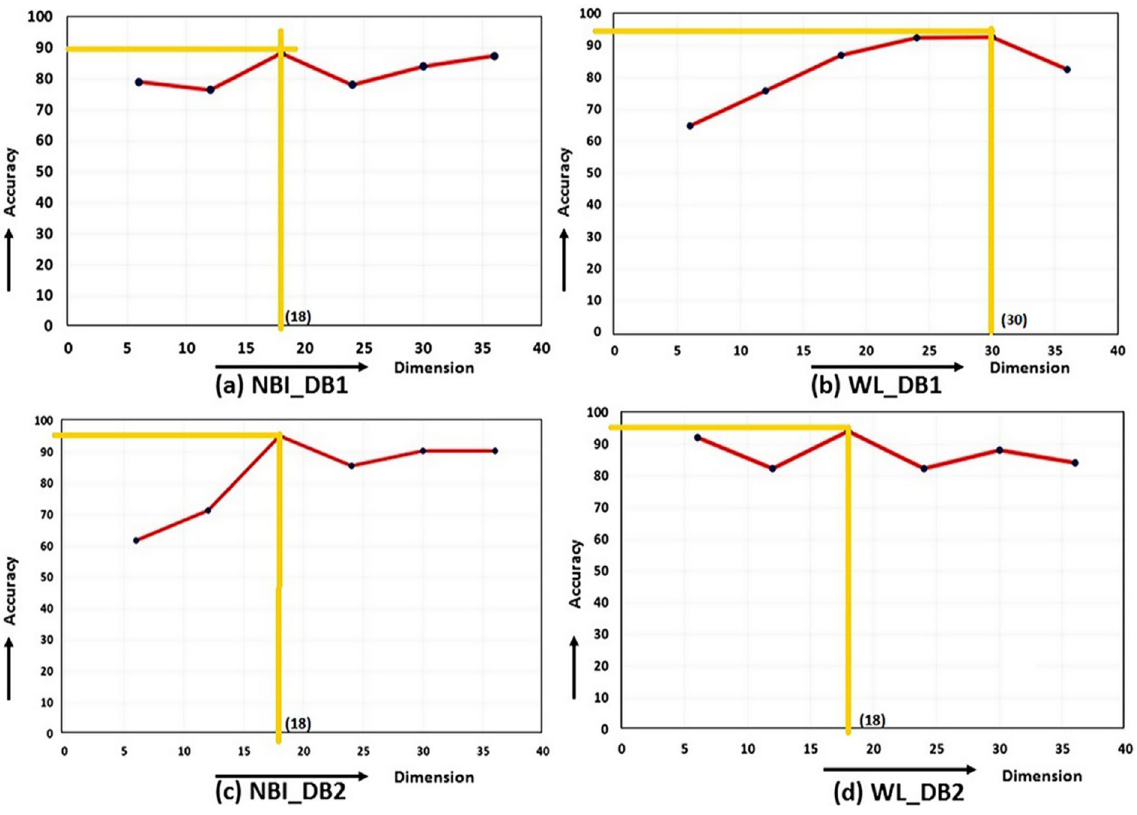
Figure 6. Feature selection in